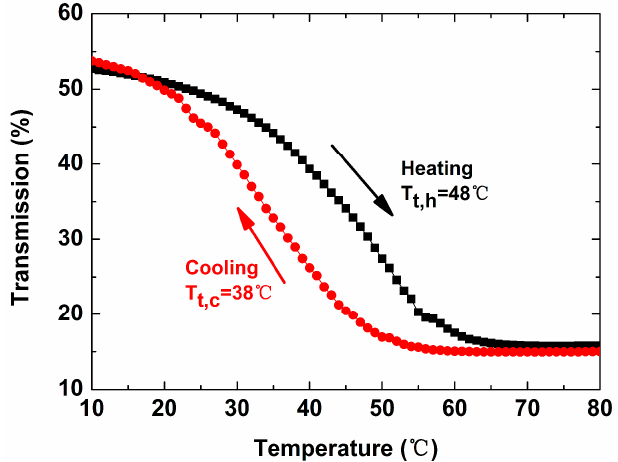
Figure 5. Thermal hysteresis loop of V 0.99 W 0.01 O 2 film at 2000 nm. The black curve indicates that the transition temperature is 48 ◦ C when the sample is heated, and the red curve indicates that the transition temperature is 38 ◦ C when the sample is cooled.